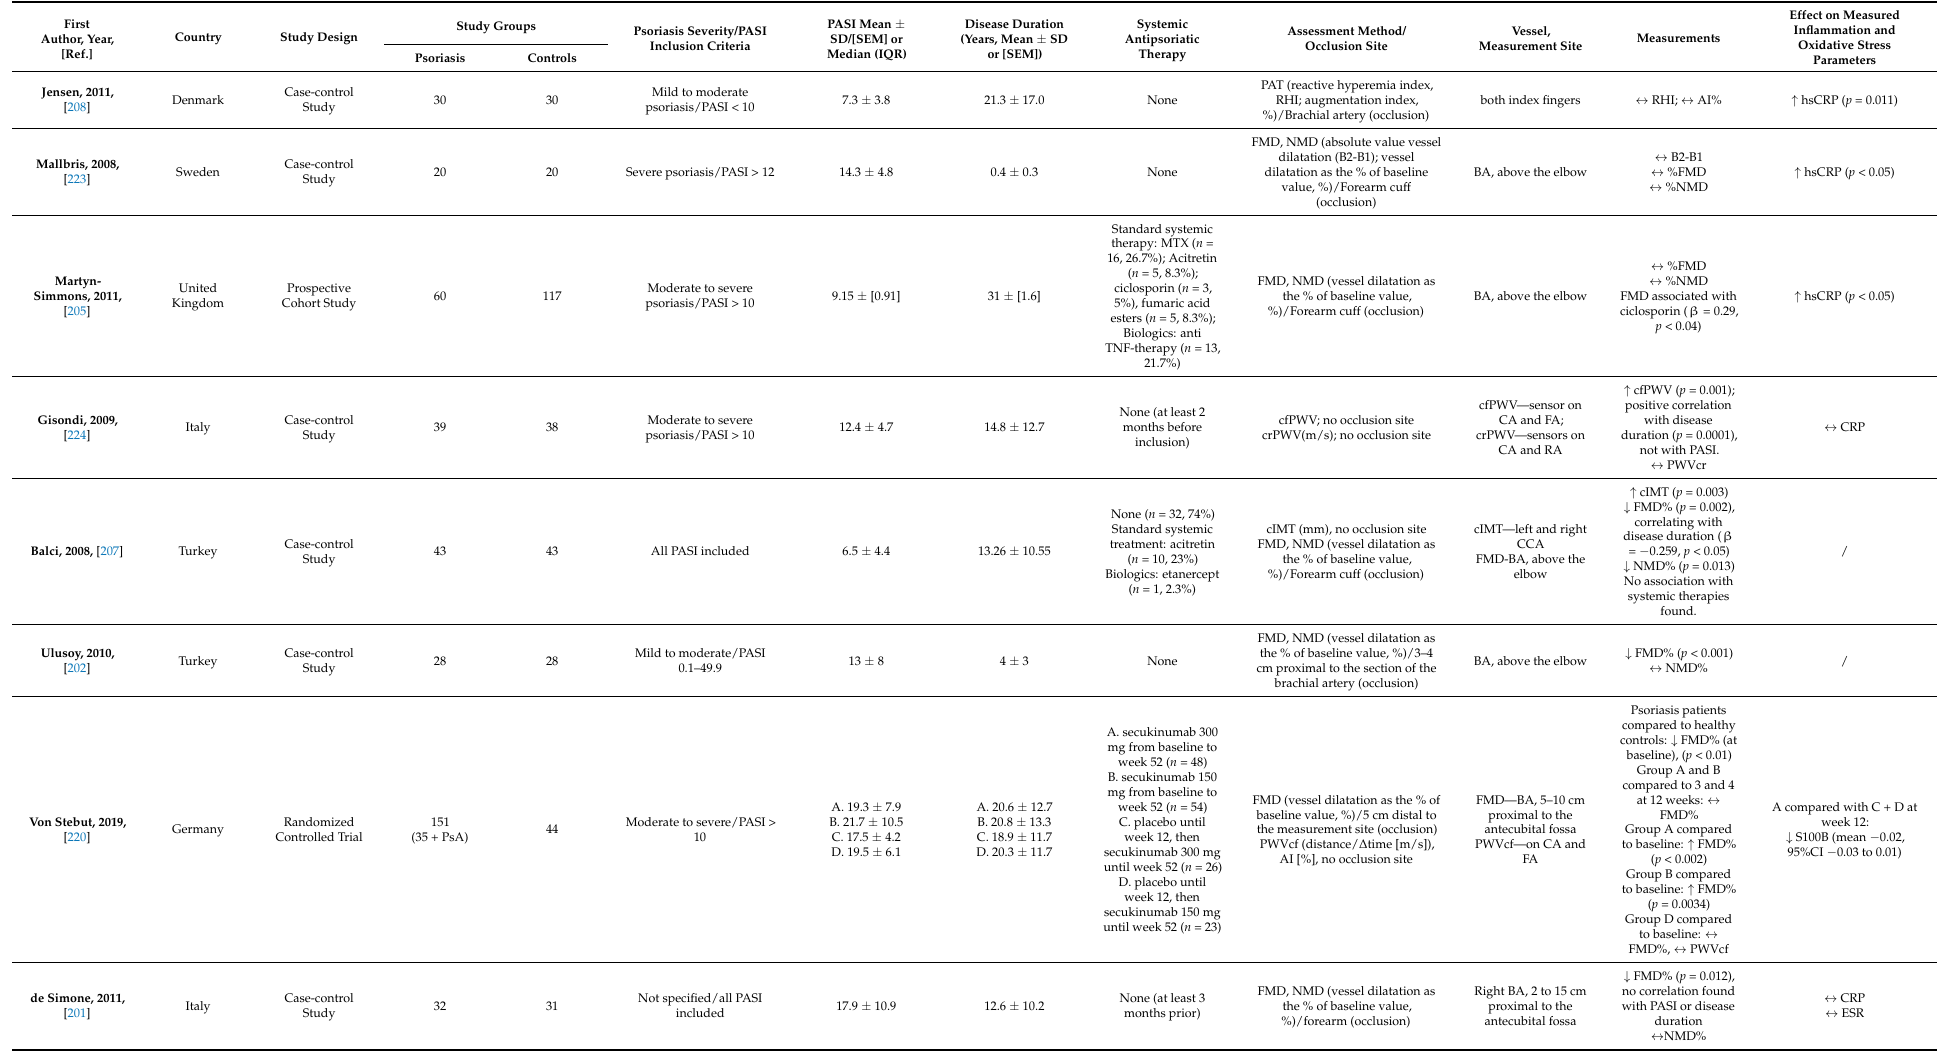
Table 1. Endothelial dysfunction in psoriasis and evidence of oxidative stress and